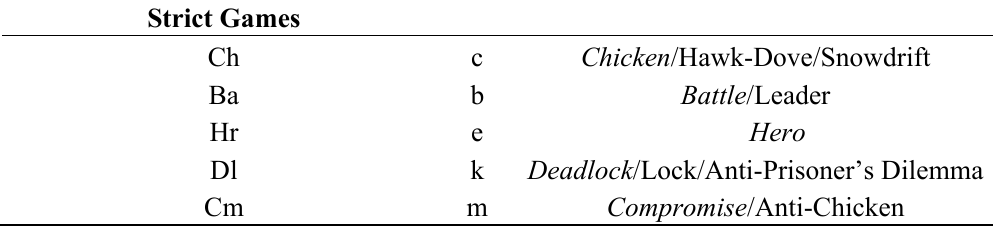
Table 1. Abbreviations provide a compact notation for 2 × 2